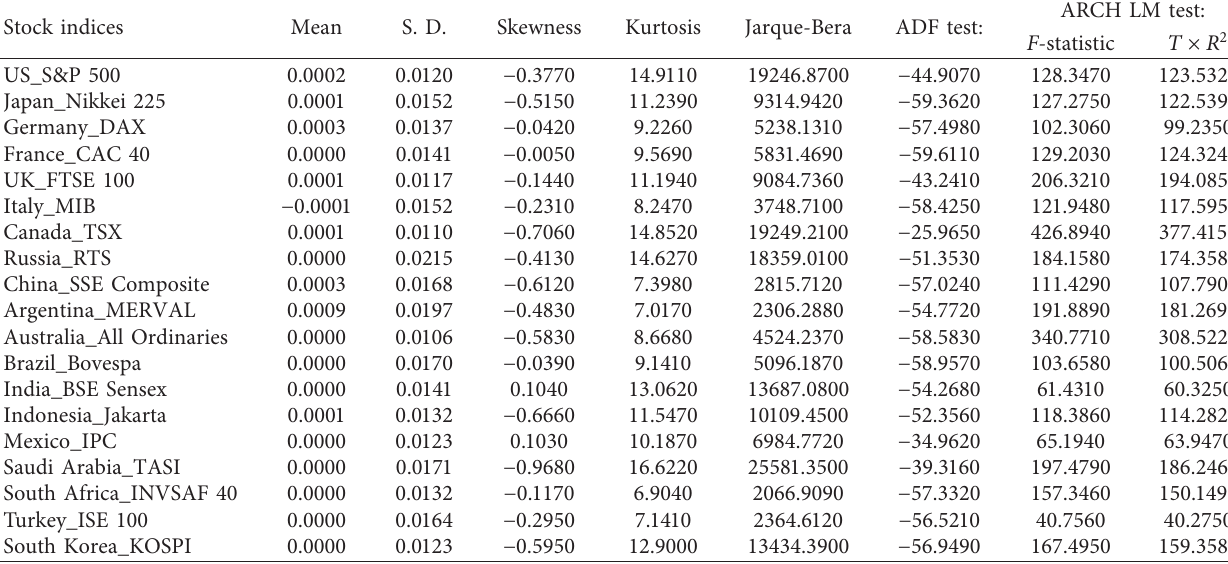
Table 1: Summary descriptive statistics of G20 stock returns.